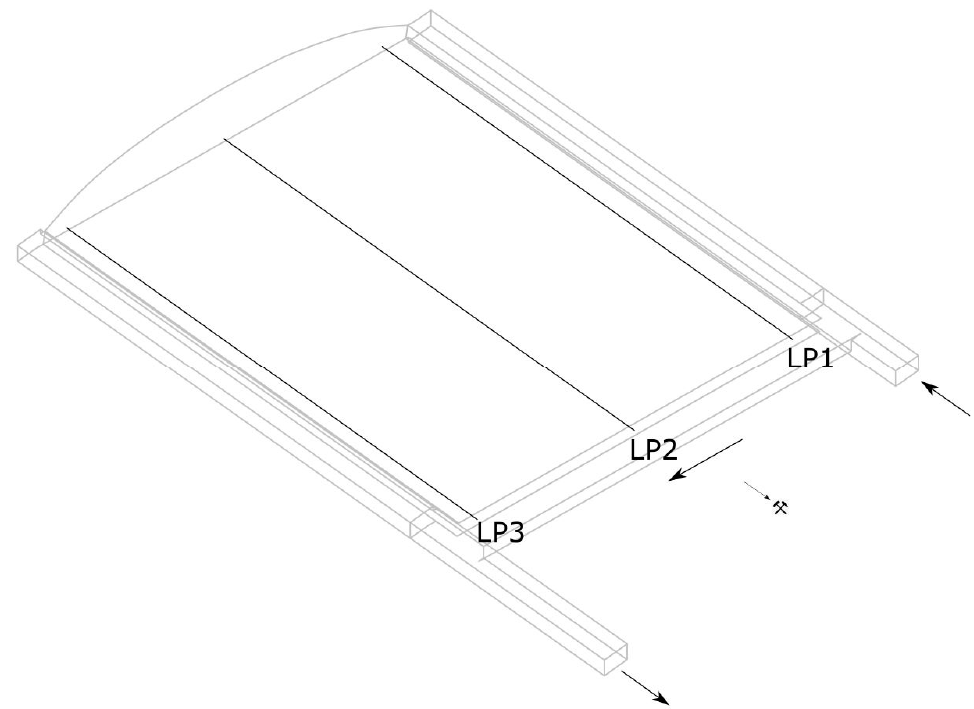
Figure 7. The location of measuring lines in goaf.